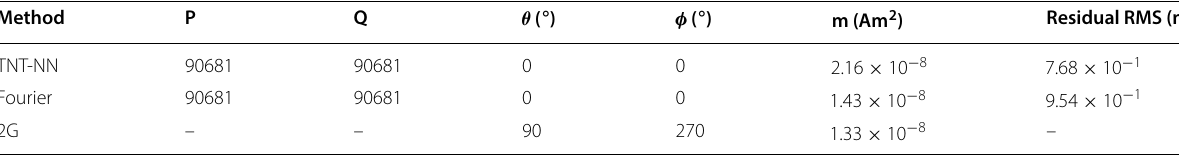
The first column shows the method used to obtain results: the numerical method or a 2G Enterprises Superconducting Rock Magnetometer (2G, shown in final row). The second column, P , is the number of sample points collected by the scanning SQUID microscope. The third column shows that we set the number of dipoles, Q , equal to the number of samples for this inversion. The fourth and fifth columns give the unidirectional orientation of the dipoles as used for NNLS analysis. The sixth column lists the moment, m . The final column provides the residual RMS of the NNLS fits with the B z